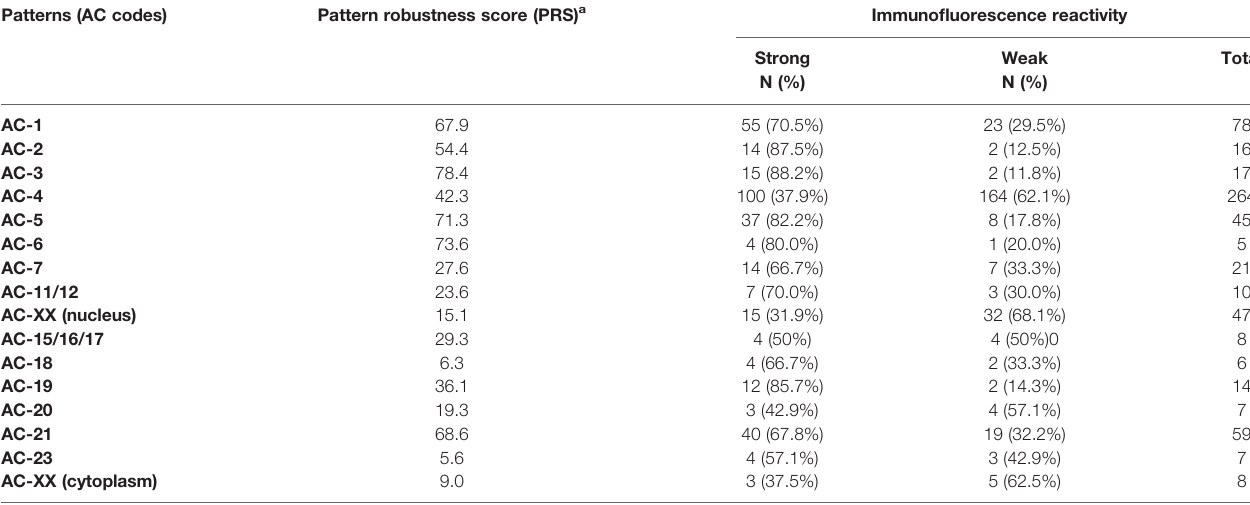
TABLE 4 | Robustness of HEp-2-IFA patterns is associated with strong reactivity in the indirect immuno fl uorescence assay. Patterns (AC